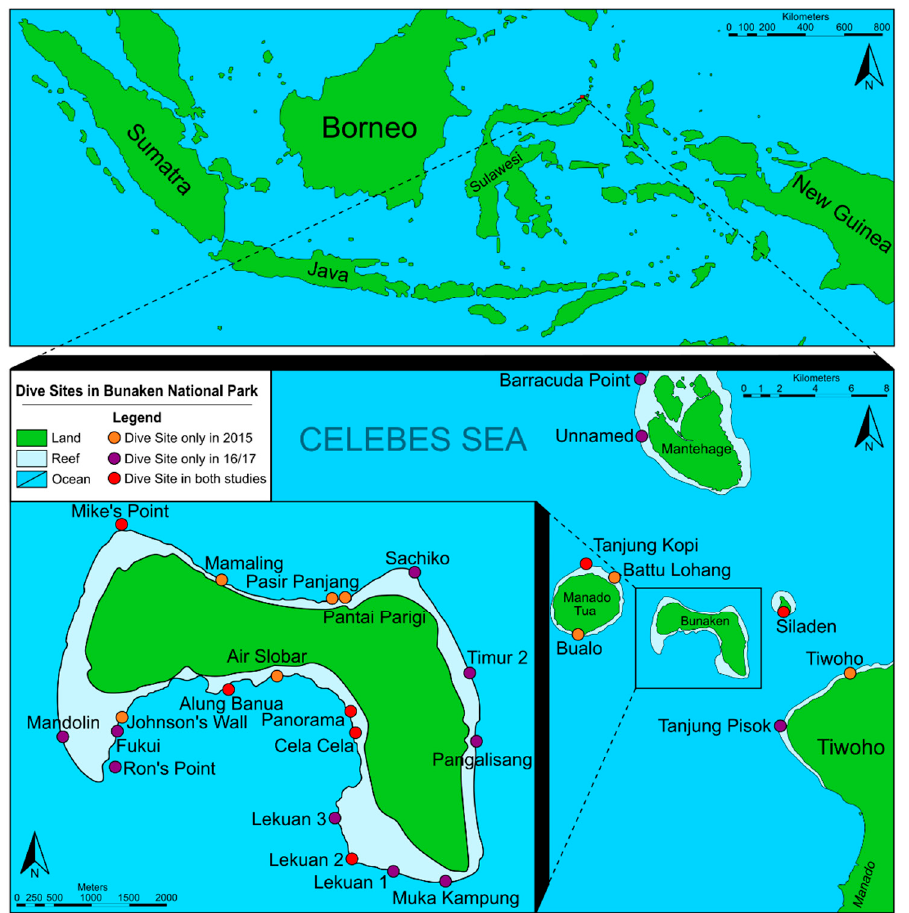
Figure 1. Location of study area: ( A ) Indonesia and Sulawesi with dashed lines indicating the close-up area in (B); ( B ) Diving sites (orange dots only in 2015, purple only in 2016 and 2017, and red in both studies) in Bunaken National Park and the islands sampled.